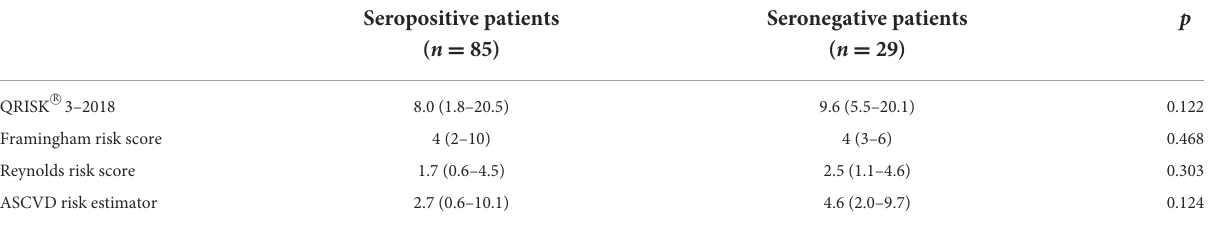
TABLE 2 Risk of coronary heart disease or stroke at 10 years.